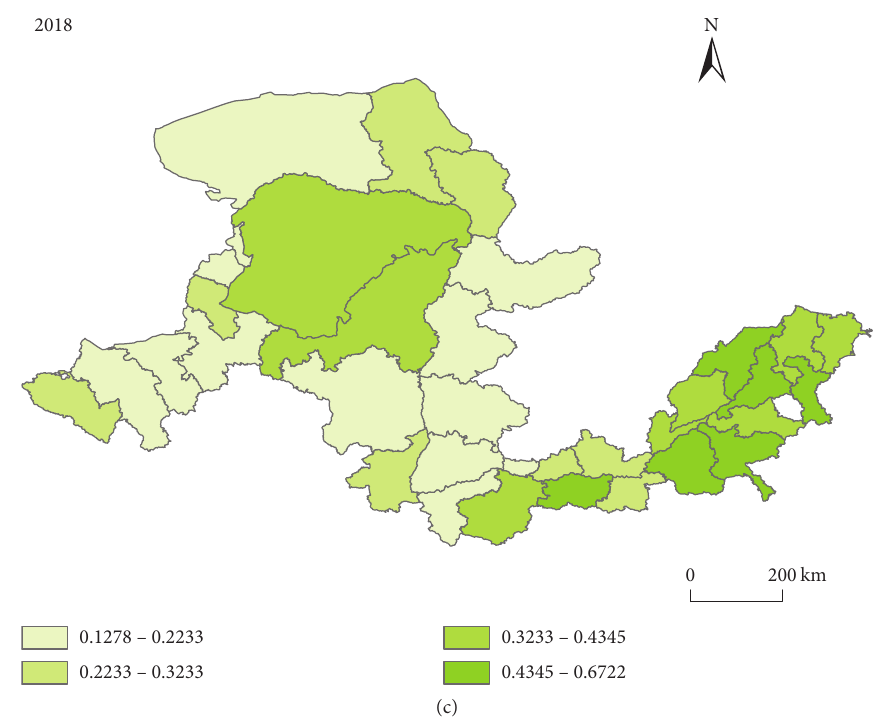
Figure 2: IGD of cities in YRB in 2012, 2015, and 2018.